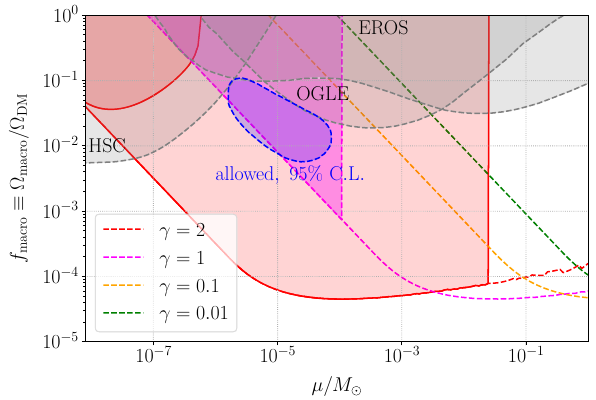
Fig. 3 Minimum value of dark-matter fraction f macro that LISA can detect as a function of macro mass μ . The upwards-bending branch of the γ = 2 (red, solid) curve uses τ min = H − 1 , while the straight 0 lines take τ min = 5years. The dark-matter distribution is the same as in Fig. 1. The solid lines and filled regions show the parameter space where the signal is well-described as a gravitational-wave back- ground. Dotted lines show an extrapolation of the stochastic sensitivity in a regime where individual sources may be resolvable. In grey, we show microlensing constraints from HSC/Subaru [42], EROS [37] and OGLE [86,87]. The blue region displays the recently reported positive detection of ultra-short time-scale events attributable to planetary-mass objects between 10 − 6 and 10 − 4 M (cid:2) [78]. These would contribute